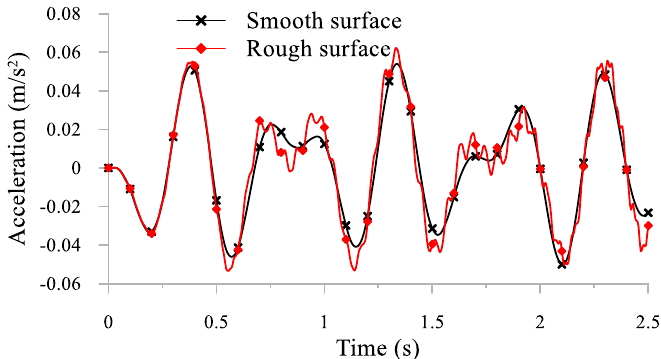
Figure 13. Acceleration response of the undamped stationary vehicle on a bridge with rough and smooth surfaces.